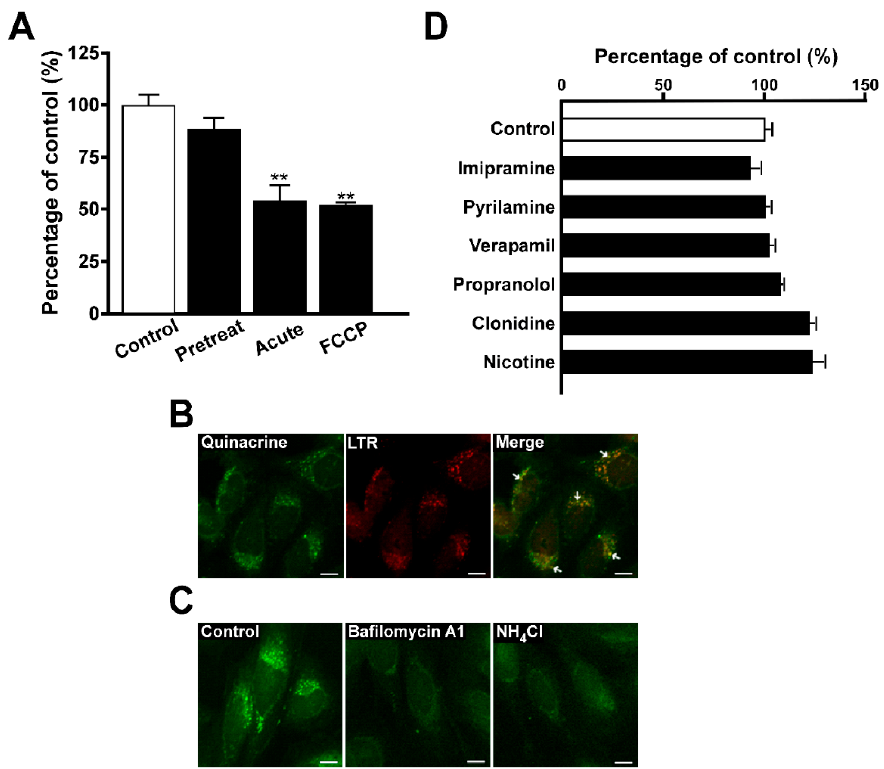
Figure 2. Effect of intracellular pH modulators on quinacrine uptake by TR-iBRB2 cells. ( A ) The quinacrine uptake was examined in the presence or absence of 30 mM NH 4 Cl at 37 °C for 30 min. In a pretreat condition, cells were treated with 30 mM NH 4 Cl, and the uptake of quinacrine (5 μ M) was performed in the absence of NH 4 Cl. In an acute condition, cells were treated with ECF-buffer, and quinacrine uptake was performed in the presence of 30 mM NH 4 Cl. The uptake was also examined in the presence of 50 µ M FCCP at 37 ◦ C for 30 min. ( B ) Confocal microscopy was carried out to investigate the intracellular distribution of quinacrine and LTR. The uptake of quinacrine (5 µ M, green) and LTR (300 nM, red) was carried out at 37 ◦ C for 30 min. ( C ) Confocal microscopy was carried out to investigate the intracellular distribution of quinacrine in the presence of intracellular pH modulator, such as 100 nM bafilomycin A1 and 30 mM NH 4 Cl. The uptake of quinacrine (5 µ M, green) was carried out at 37 ◦ C for 30 min. ( D ) Inhibitory e ff ect of cationic drugs on quinacrine uptake was examined in the presence of bafilomycin A1. After the treatment of TR-iBRB2 cells with 100 nM bafilomycin A1 at 37 ◦ C for 30min, quinacrine uptake was examined in the presence of 100 µ M cationic drug at 37 ◦ C for 30 min. Each column represents the mean ± S.E.M. ( n = 3–4). ** p < 0.01, significantly di ff erent from the